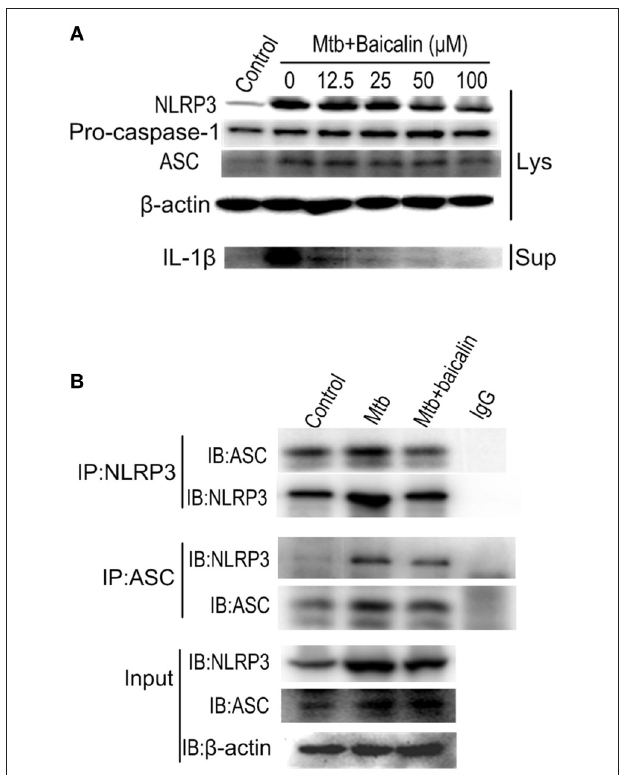
FIGURE 5 | Baicalin evidently inhibits the Mtb-induced NLRP3 inflammasome activation. (A) Levels of NLRP3, ASC and pro-caspase-1 expression in cell lysates and the mature IL-1 β in the supernatant were determined by immunoblot. (B) ASC or NLRP3 immunoprecipitates from Raw264.7 cells were immunoblotted for NLRP3 or ASC respectively, and re-blotted for ASC or NLRP3 respectively. Experiment performed three times.